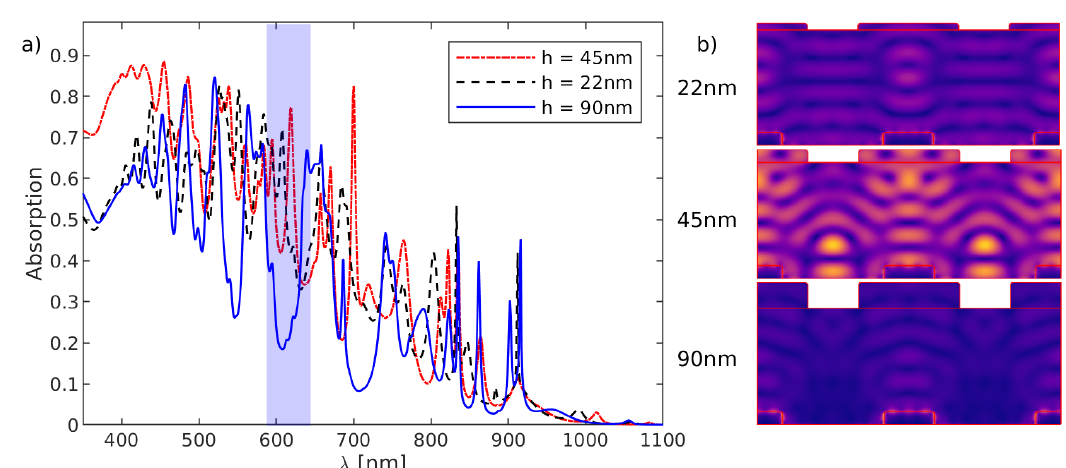
Figure 4. simulated spectral response of the reflected power in structures with a periodic back grating (red dash-dotted line) and with a periodic double grating (blue line) at ( a ) normal incidence and at ( b ) π tilted incidence. 8